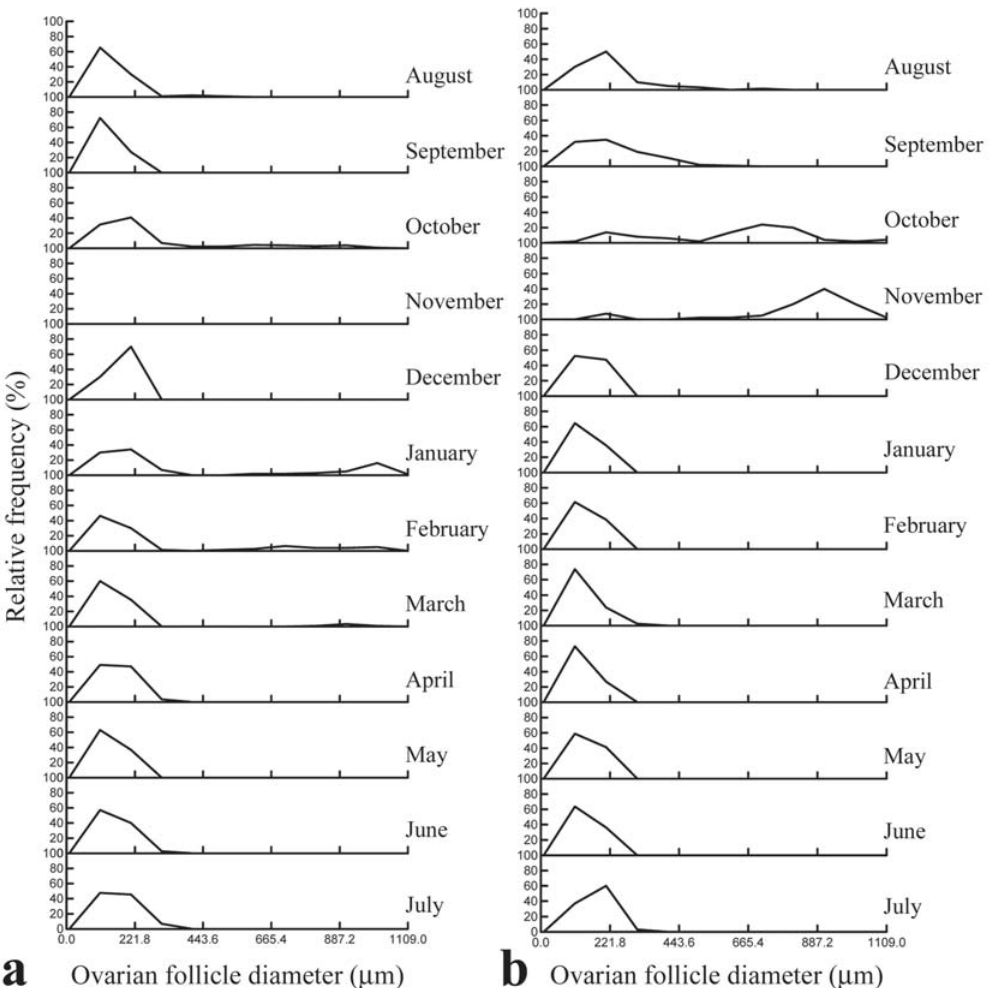
Fig. 7. Relative frequency distribution of the ovarian follicle diameter ( µ m) of P . mesopotamicus in the headwaters (a) and flood area (b) between August 2006 and July